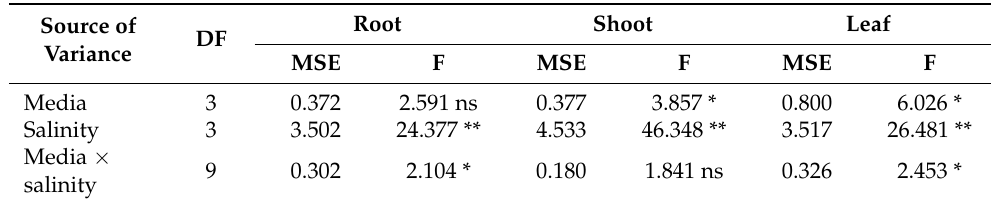
Table 3. Effect of water salinity and media composition on root, shoot, and leaf biomass (g) of 14 week old Avicenna marina (Forssk.) Vierh. seedlings.